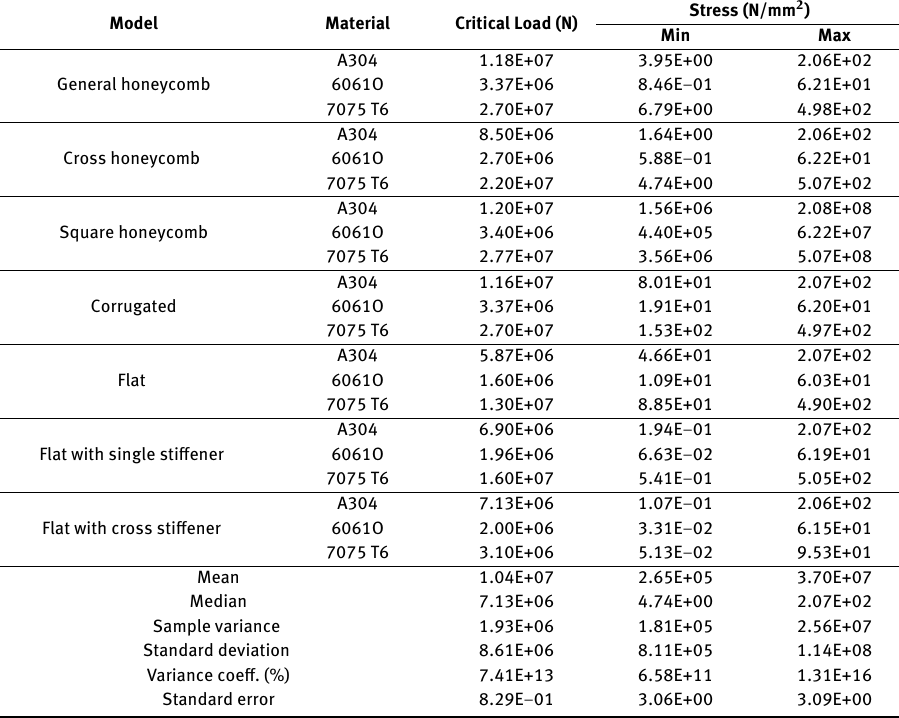
Table 7: Summary of the critical load and von Mises stress results